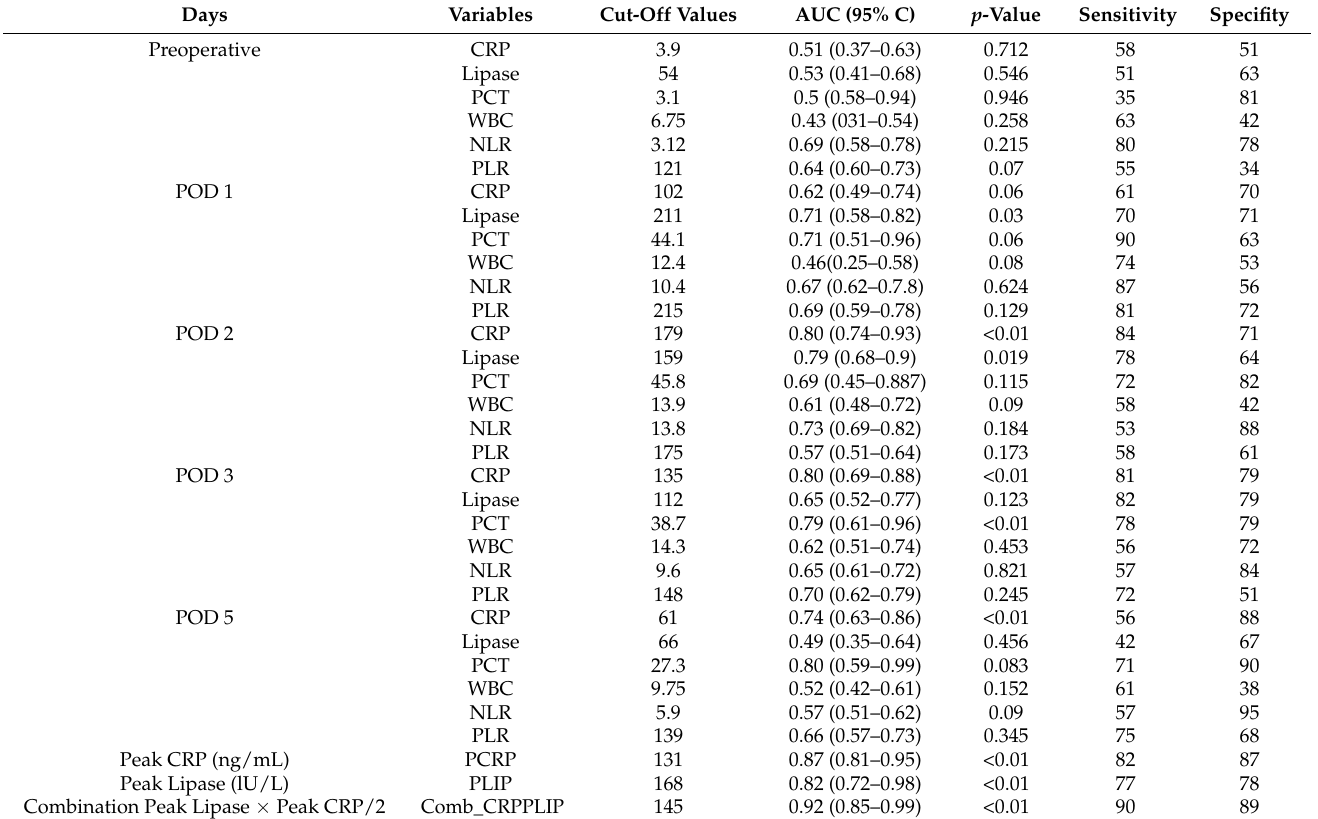
Table 4. ROC analysis of different serum markers for the prediction of early pancreatic graft dysfunc- tion following simultaneous pancreas–kidney